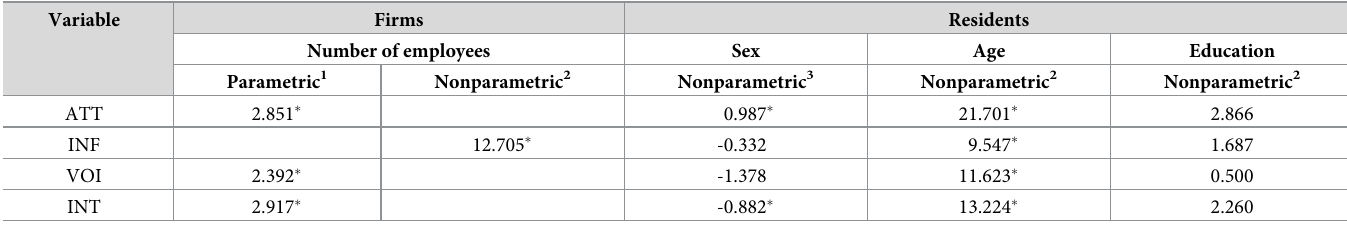
Table 5. Results of the tests for the differences between means of the groups.